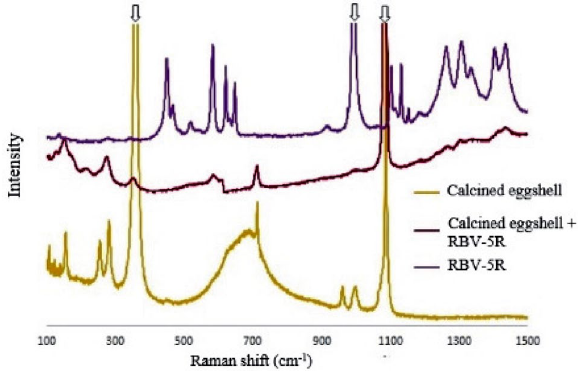
Figure 10 . Raman spectrum for control, 2 g/L RBV-5R dye ad- sorbed calcined eggshell and RBV-5R dye